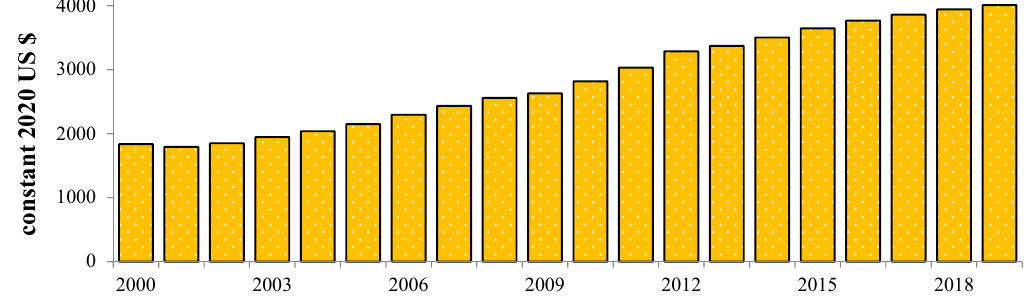
Figure 1. The real GDP per capita trends in Sri Lanka. Source: World Development Indicators [21].